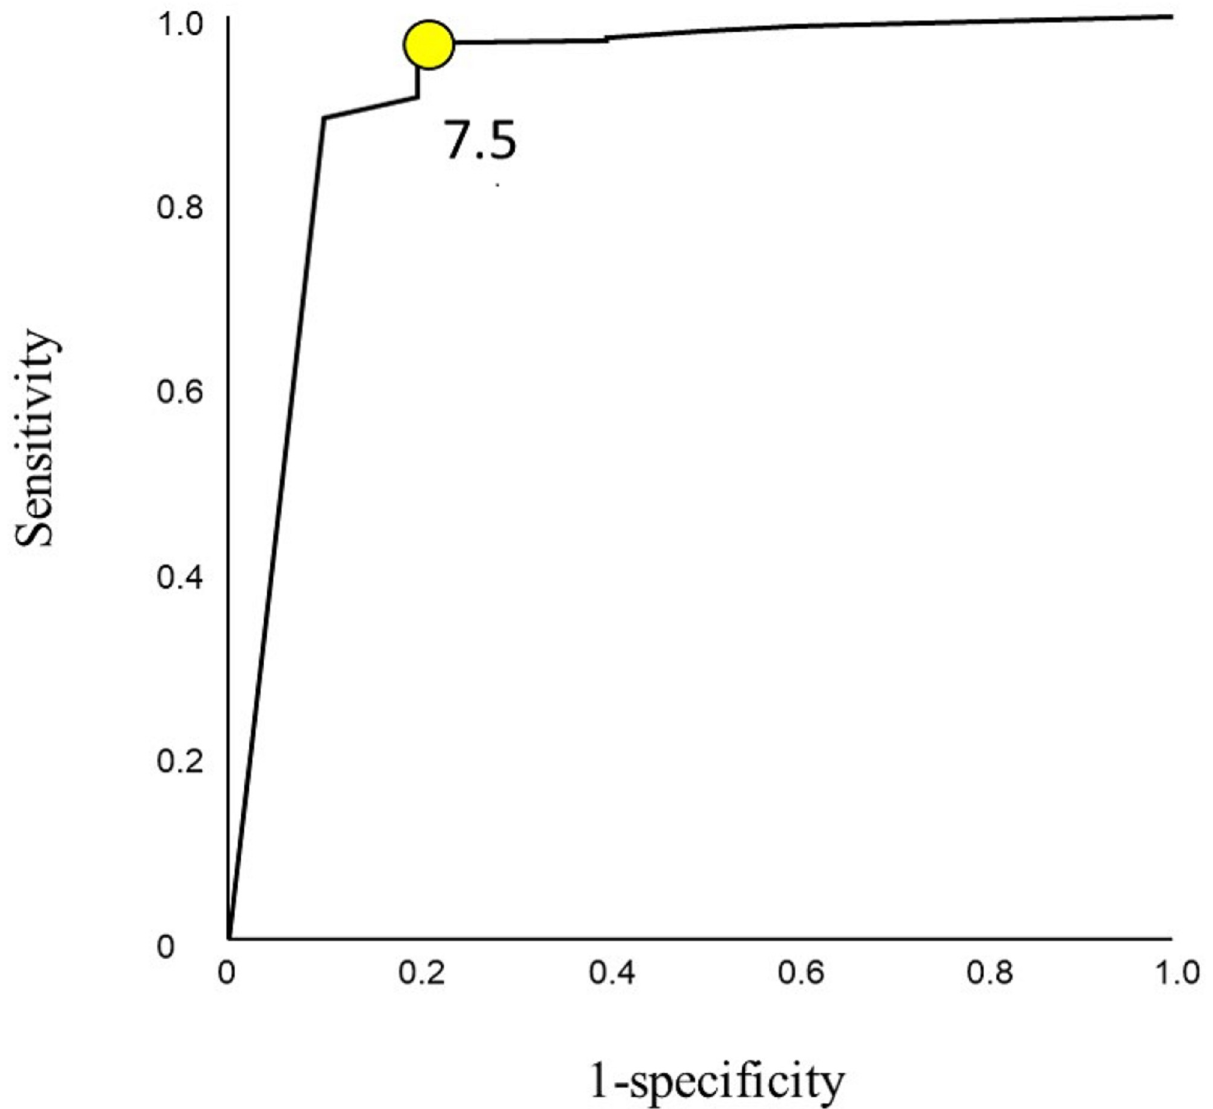
Fig 2. Receiver Operating Characteristic (ROC) curve for the best cut-off point of Glasgow Coma Scale (GCS) that predicts survival.